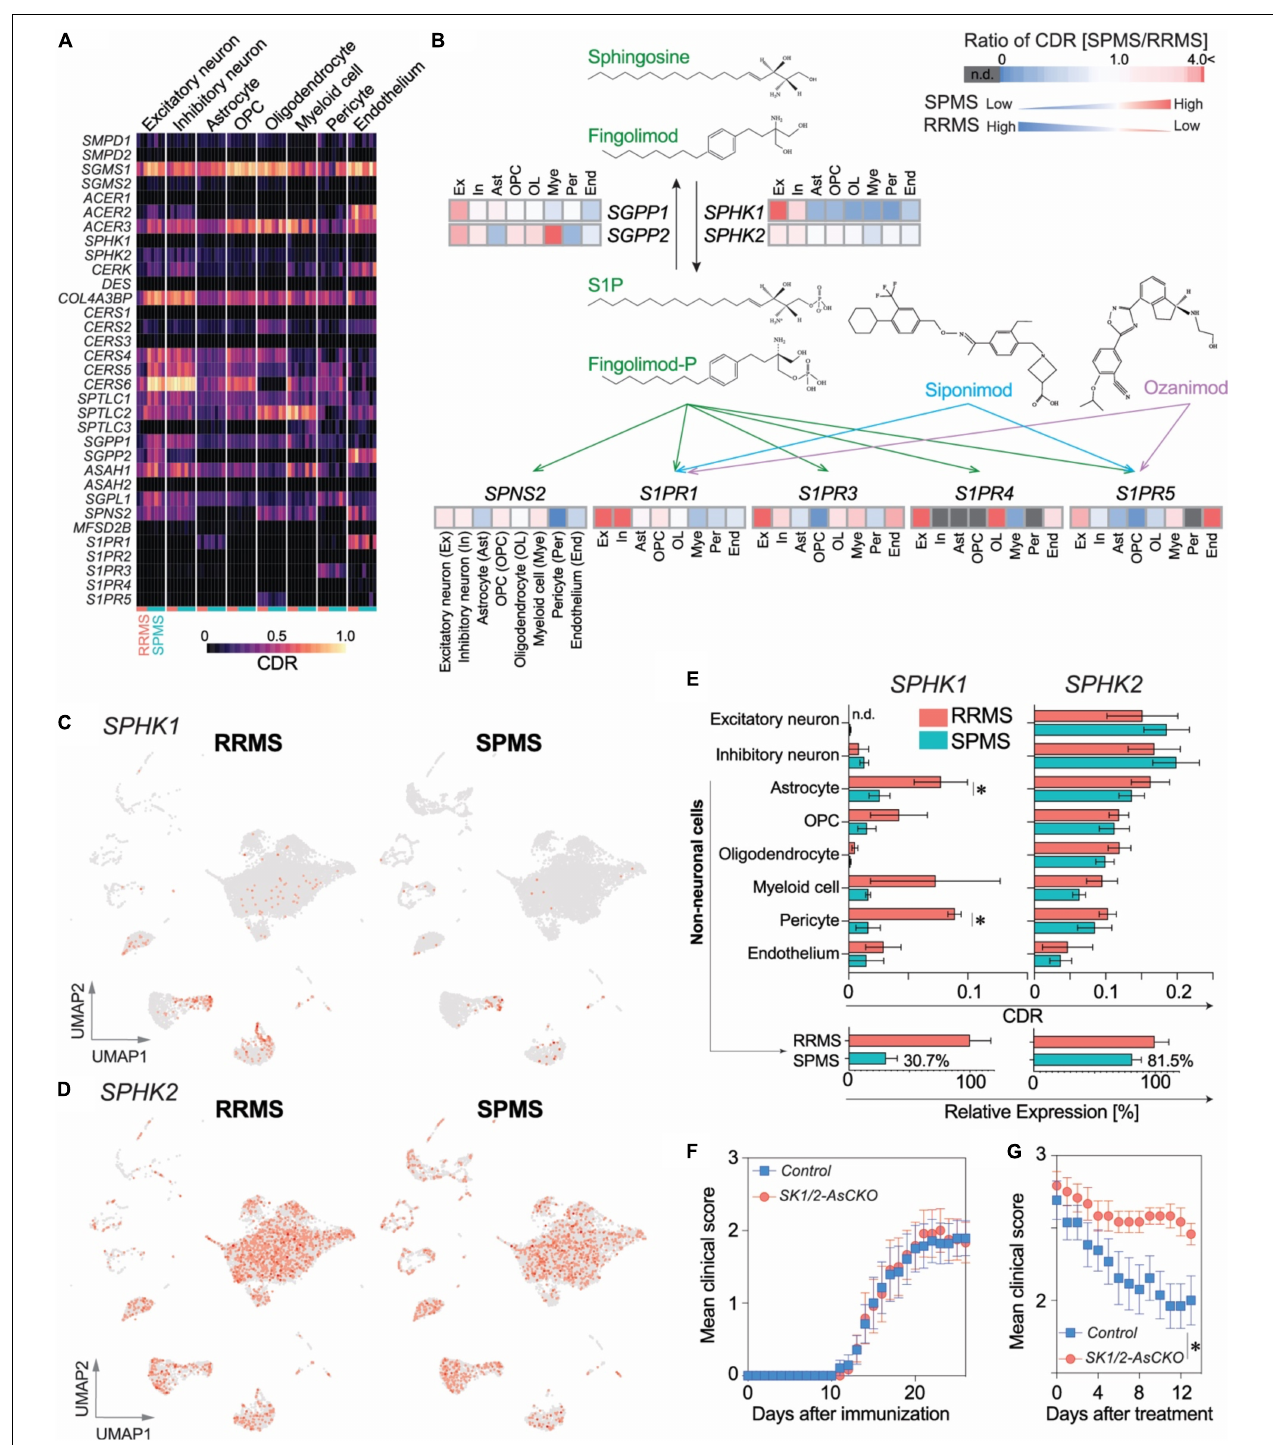
FIGURE 5 | A potential role of CNS-derived sphingosine kinases ( SPHK1/2 ) in fingolimod efficacy. (A) Heatmap of CDRs for sphingolipid pathway genes. (B) Comparison of CDR ratio between SPMS over RRMS in a pathway associated with the mechanism of action of S1P receptor modulators, fingolimod phosphate (fingolimod-P), siponimod, and ozanimod. UMAP plots of SPHK1 (C) and SPHK2 (D) . (E) Top : CDRs for SPHK1 and SPHK2 . n = 3 RRMS vs. 5 SPMS. ∗ p < 0.05 by t -test. Bottom : Reductions in SPHK1/2 expression in non-neuronal cell populations. (F) EAE disease course in Sphk1/2-AsCKO mice vs. control WT mice. n = 12 and 14 animals, respectively. (G) EAE clinical course of fingolimod-treated Sphk1/2-AsCKO mice vs. control WT mice. n = 12 and 13 animals, respectively. ∗ p < 0.0001 by two-way ANOVA. Fingolimod treatment (1 mg/kg, p.o., q.d.) started from 18 days after immunization.